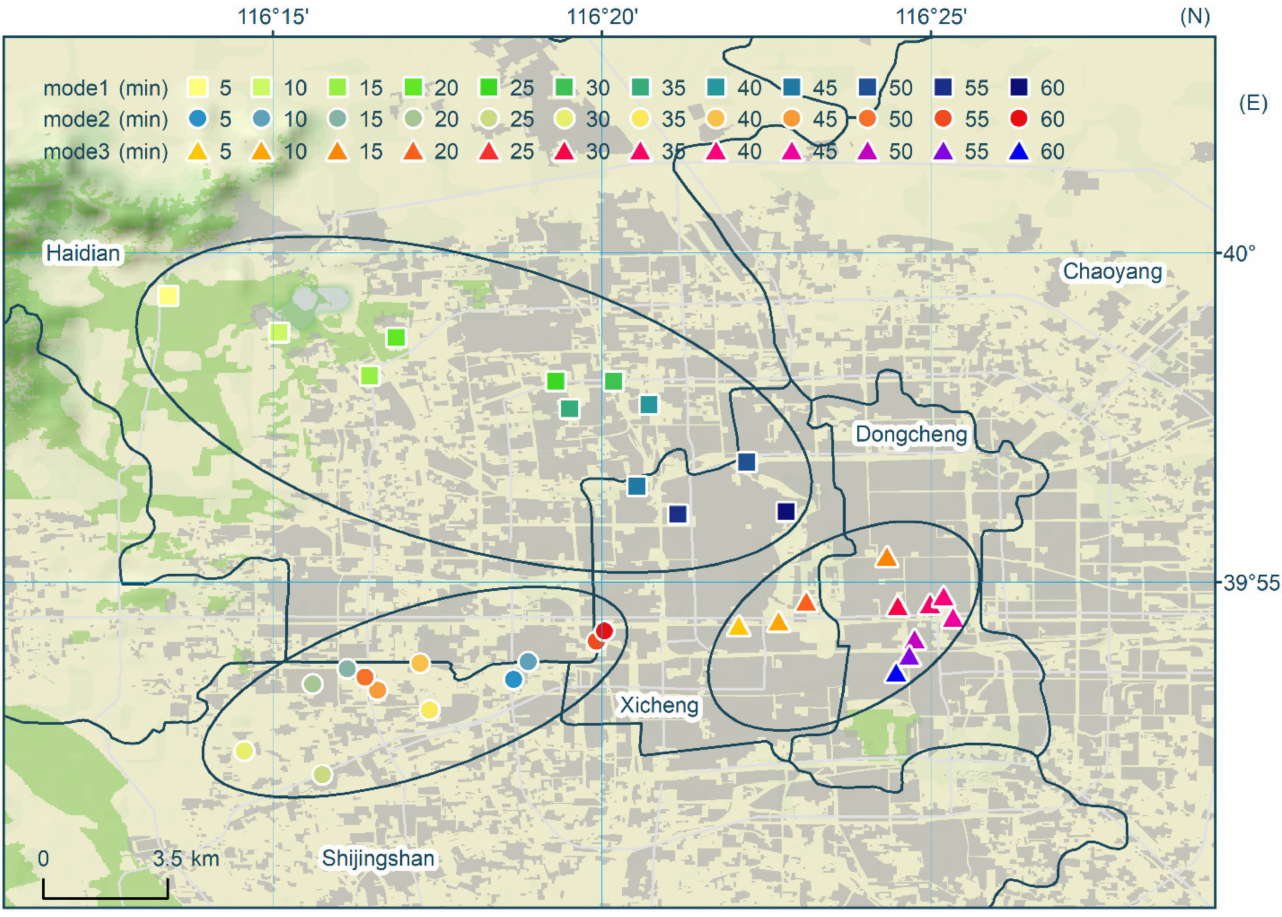
Figure 5. Centroids of three modes at different periods.